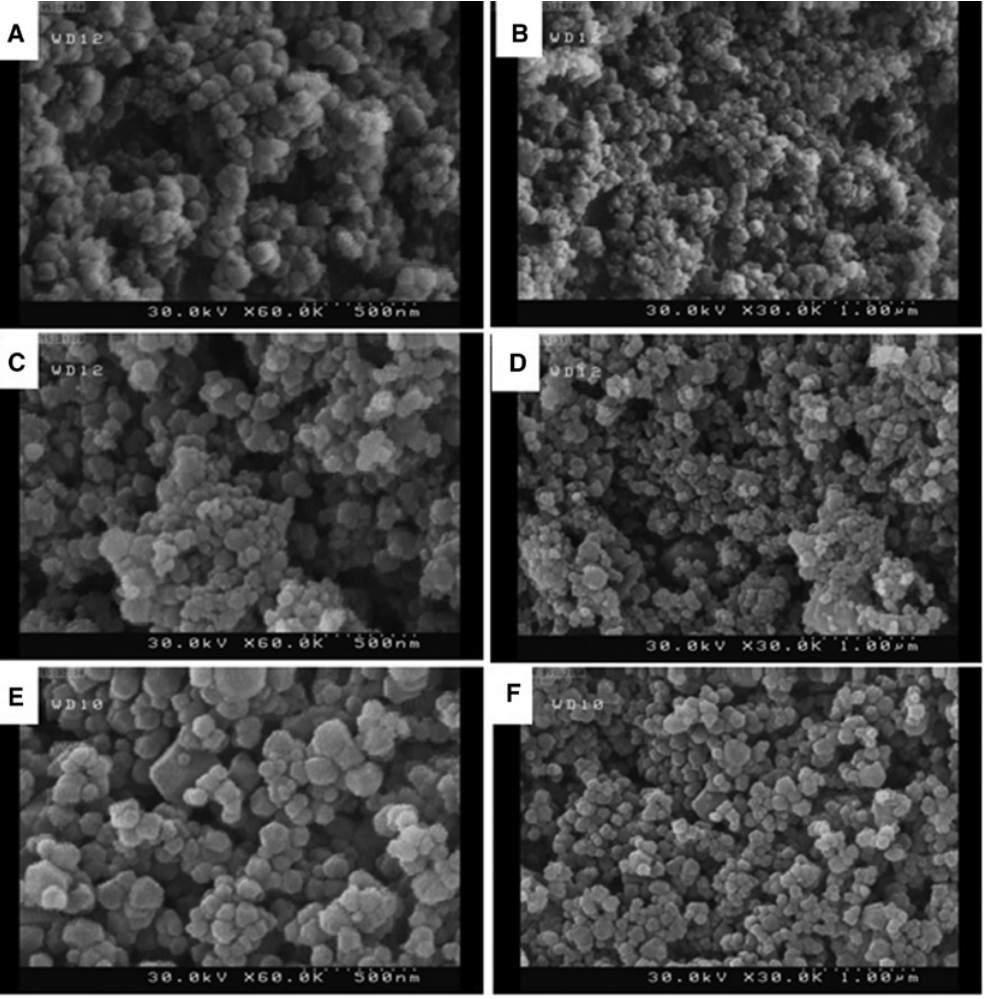
Figure 6: Field emission scanning electron microscope (FESEM) images of of Zn 2 + doped MgO nanoparticles with two magnitude that calci- nated at: (A) and (B) 600 ° C; (C) and (D) 700 ° C; (E) and (F) 800 °